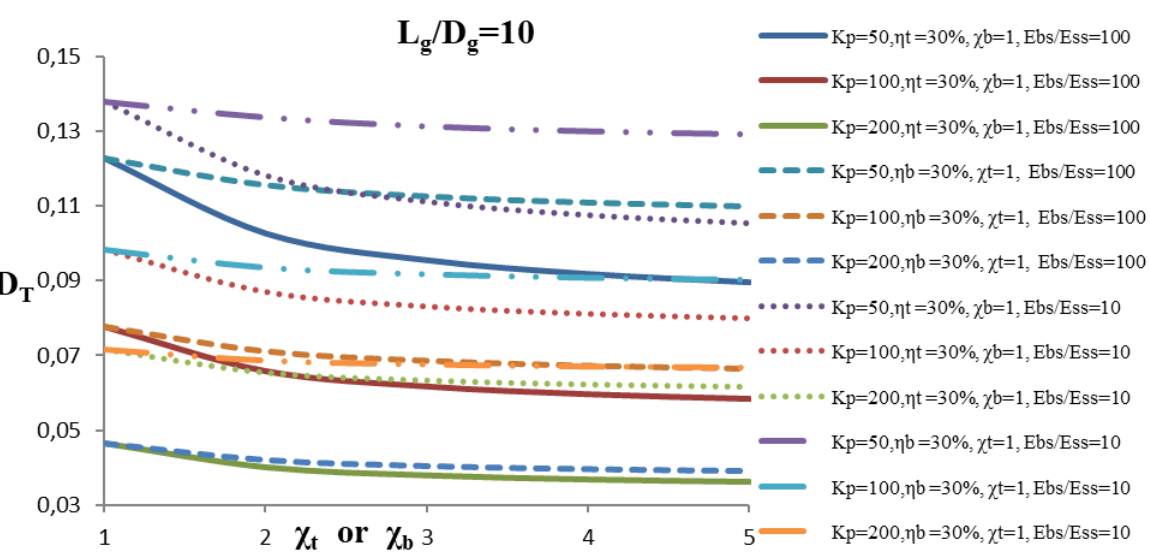
, or strengthening t